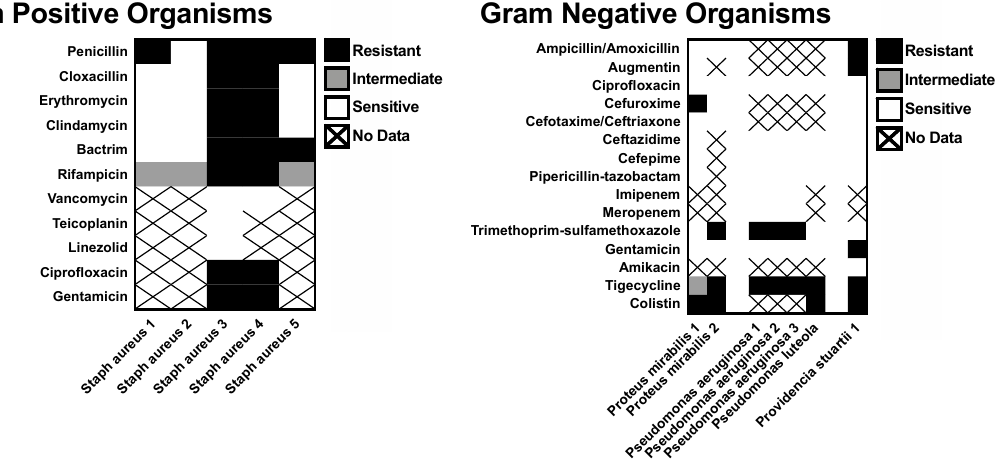
Figure 3. Antibiotic resistance. Map of resistance of isolates obtained by culture of purulent drainage